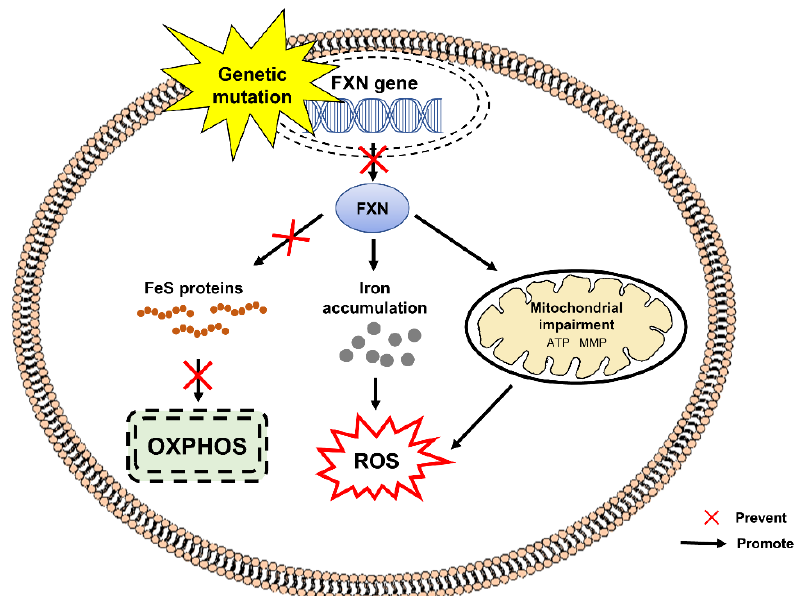
Figure 5. Mutation in the FXN gene in the pathogenesis of FRDA. An absence or deficiency of frataxin protein contributes to the disruption of FeS clusters biogenesis, disrupting oxidative OXPHOS. In addition, the protein deficiency also contributes to abnormal accumulation of iron and mitochondrial impairment, leading to excessive production of ROS. ATP, adenosine triphosphate; FXN, frataxin; FeS, iron-sulfur; MMP, mitochondrial membrane potential; OXPHOS, oxidative phosphorylation; ROS, reactive oxygen species.